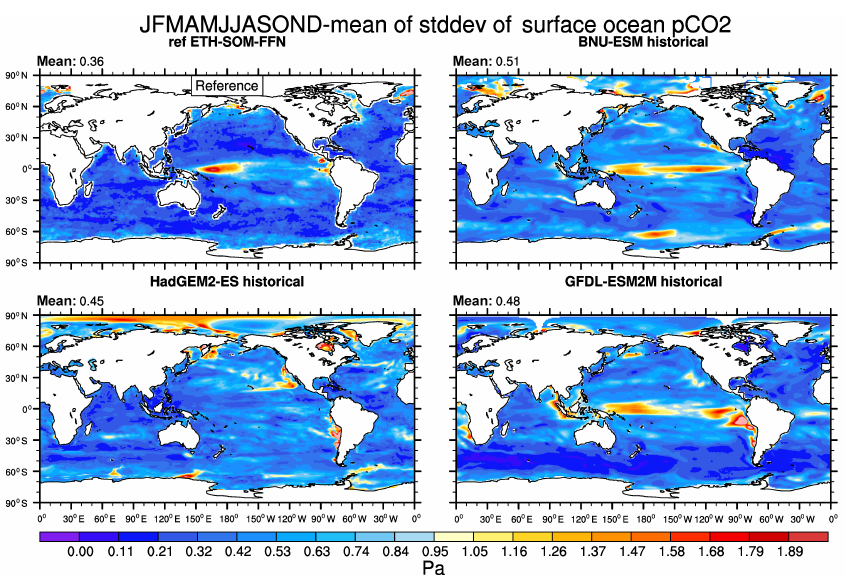
Figure 22. Interannual variability in de-trended annual mean surface p CO 2 (Pa) for the period 1998–2011 from an observation-based reference product (ETH-SOM-FFN; upper left) and three CMIP5 models (1992–2005). The spatial structure of interannual variability differs between individual CMIP5 ESMs; however, both BNU-ESM and GFDL-ESM2M are able to reproduce pronounced variability in surface ocean p CO 2 within the equatorial Pacific, primarily associated with ENSO variability (Rödenbeck et al., 2014). Produced with